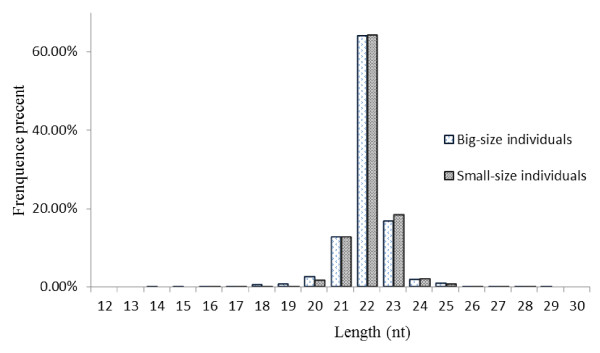
Length distribution of small RNAs in
M. amblycephala
.